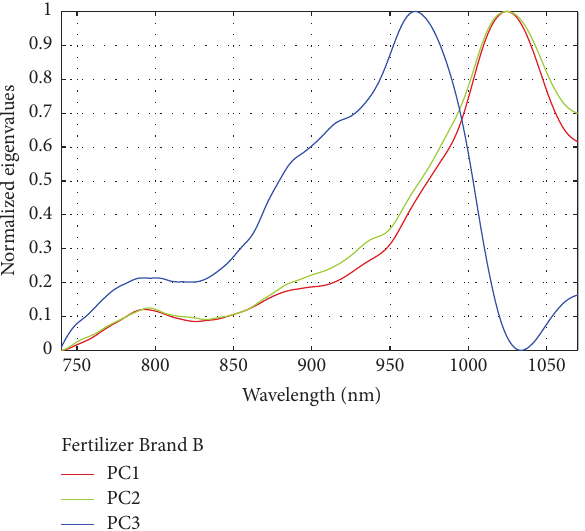
Figure 6: Eigenvectors for the identifcation of fertilizer brand B Table 3: Te infuence of preprocessing technique on identifcation models (fertilizer B). Models